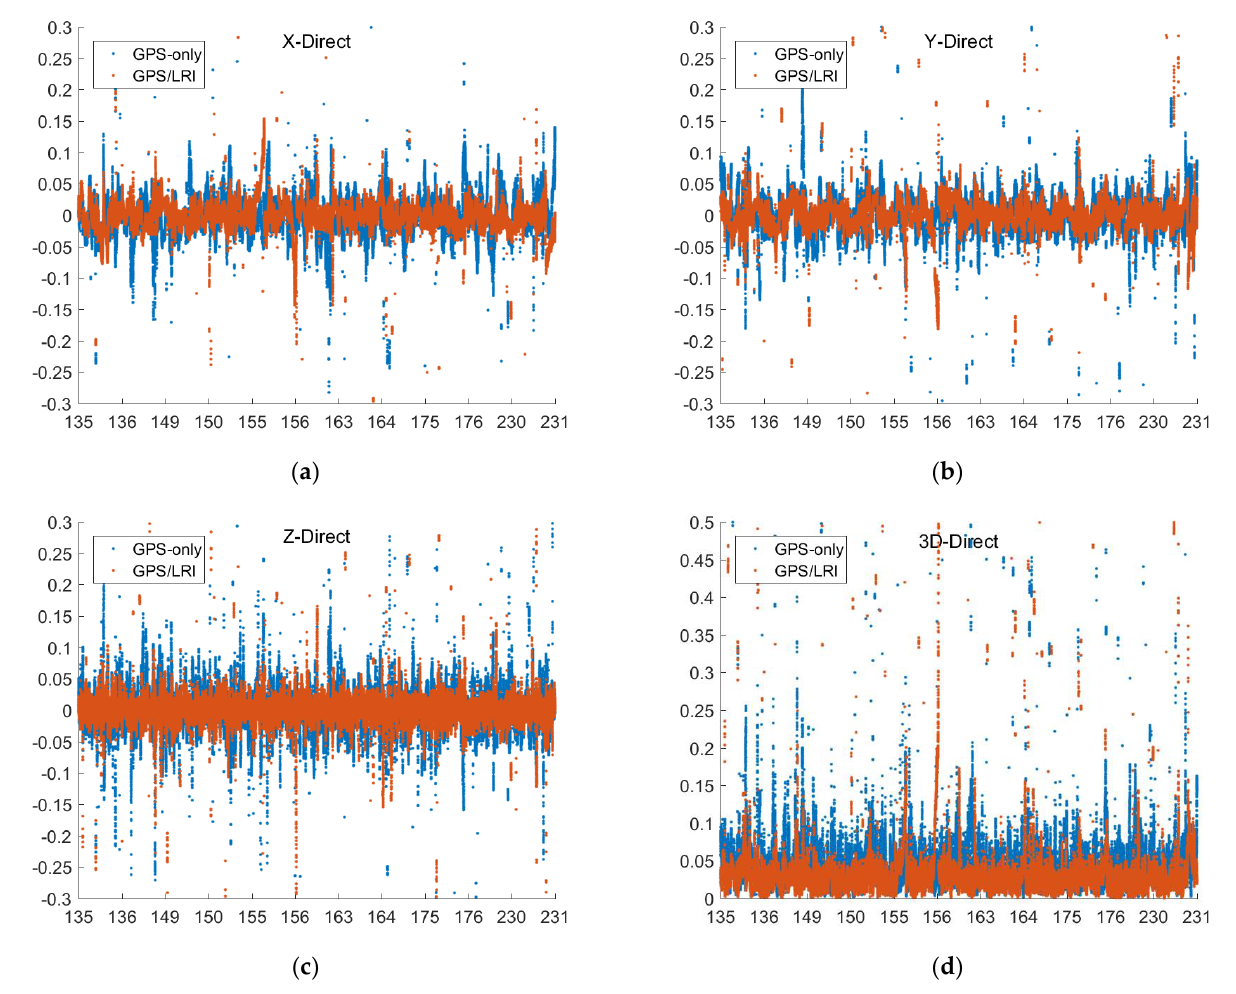
Figure 14. Reference orbit check for Orbital Maneuver in the X, Y, Z, 3D (X, Y, Z are components of the baseline vector, unit: m, ( a – d )) directions (days 121–242). Table 10. Statistics of X, Y, Z and 3D residual (unit: m, days 121–242) in Orbital Maneuver.